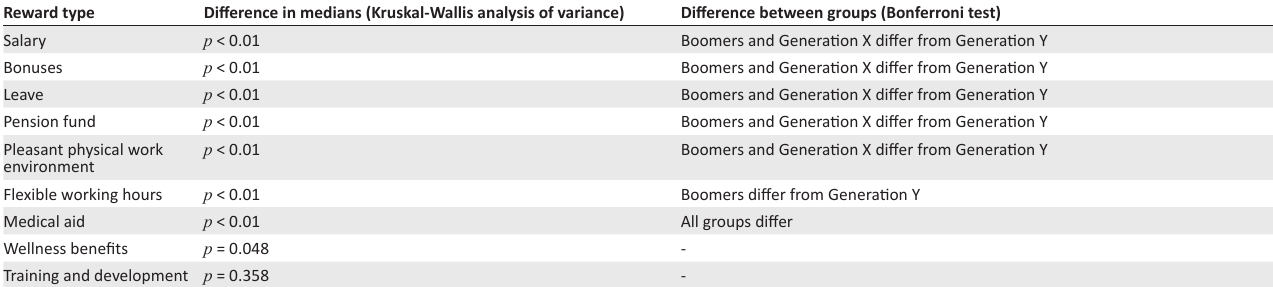
TABLE 11: Employee satisfaction with reward package received. Reward